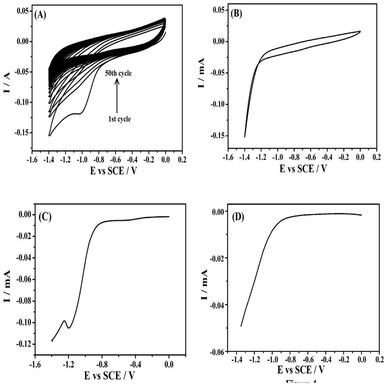
(A) Cyclic voltammograms of GQDs/PPy-2/GCE in 0.2 M PBS of pH 7.0 for 50 cycles. (B) The first cycle on the cyclic voltammograms of bare GCE in 0.2 M PBS of pH 7.0. Differential pulse voltammograms of GQDs/PPy-2/GCE in 0.2 M PBS of pH 7.0 before (C) and after (D) its electrochemical reduction.